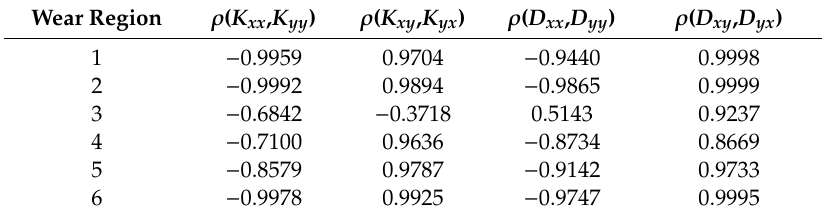
Table 4. Coe ffi cients of dimensionless dynamic coe ffi cients for circumferential wear. Wear